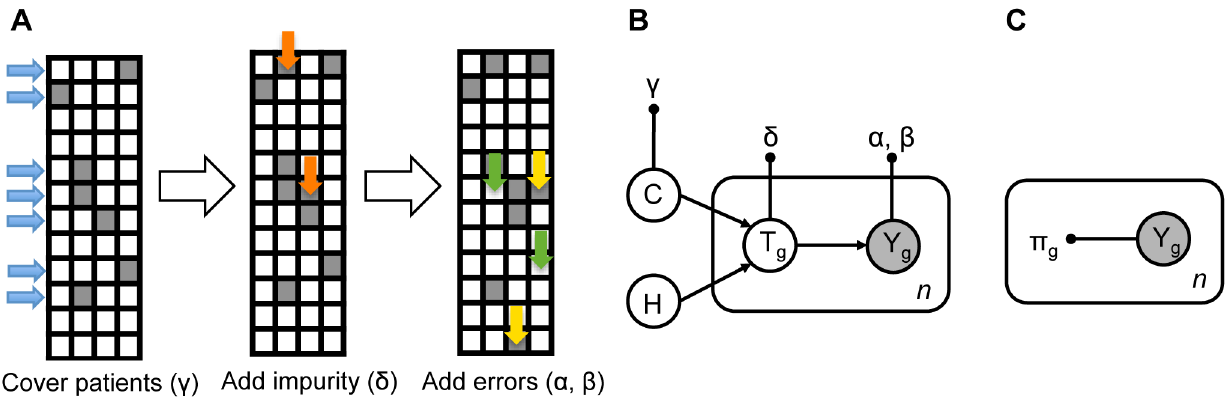
Figure 1. Principles of the mutual exclusivity model and test. A The generative process underlying mutual exclusivity patterns. The matrices show alteration status (shaded for presence and white for absence of alteration) for genes (columns) in patients (rows) in consecutive steps of the process, each dependent on parameters indicated in brackets. Blue arrows point at patients that are covered by the pattern with probability c . Orange arrows point at impure alterations, added with probability d . Yellow and green arrows show false positives (added with rate a ) and false negatives (rate b ), respectively. B Graphical representation of the mutual exclusivity model. Large circles: random variables, with observed variables shaded. Small black circles indicate model parameters, and are connected to their corresponding variables with edges. Arrowed edges show dependencies between variables. The rectangle plate indicates a set of identically distributed variables or a set of their parameters (with indices g [ f 1, ::: , n g ). C The independence